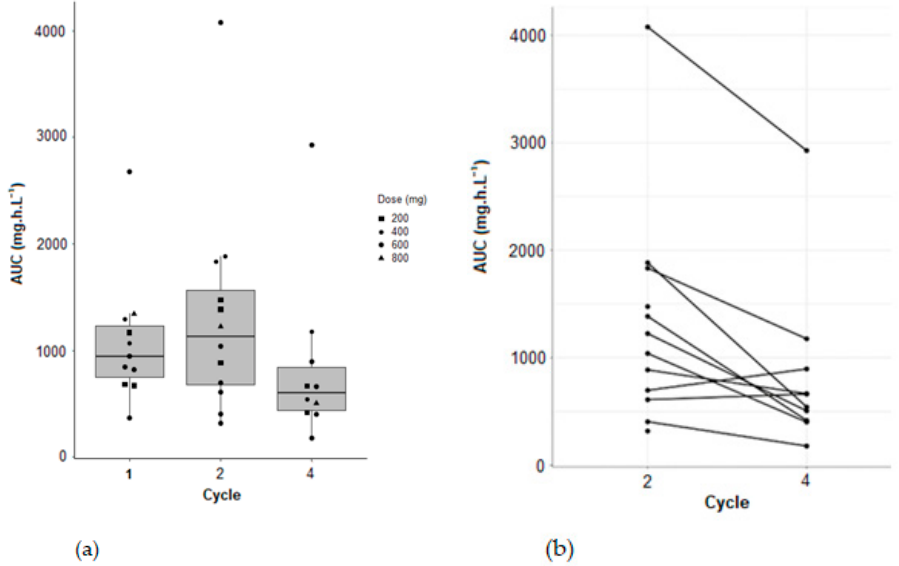
Figure 6. ( a ) Evolution of AUC across the cycle of treatment; ( b ) comparison of AUC between cycle 2 and cycle